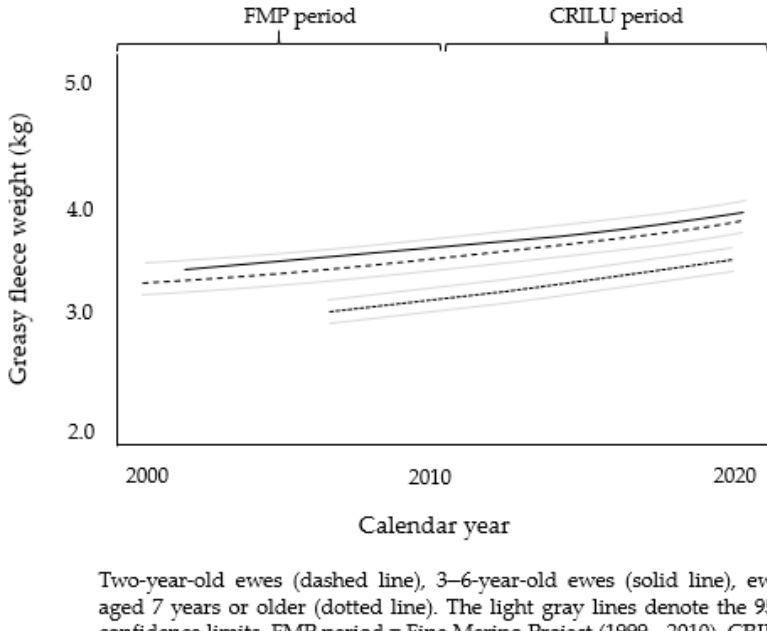
Figure 2. Two-year-old ewes, 3–6-year-old ewes, and ewes aged seven years or older phenotype trends using a second-degree polynomial regression model for the average greasy fleece weight across calendar years